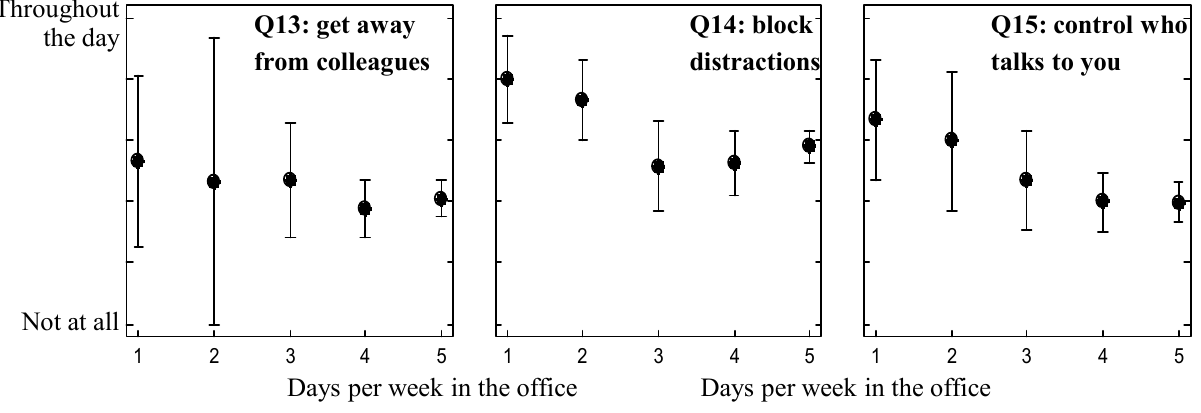
Figure 4. How the need to carry out privacy behaviours changes for people who spend a different number of days in the office each week. People who spend less time in the office feel a greater need to control